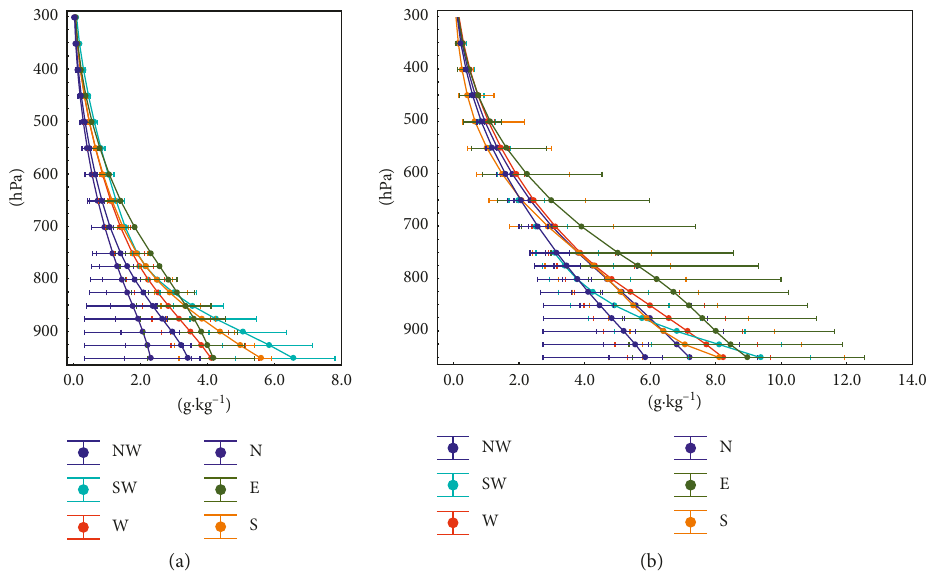
Figure 3: Monthly mean specific humidity (SHUM) vertical profiles at selected grid points (for details, see Figure 1 and Table 1); whiskers show the range defined by minimum and maximum SHUM values in a moisture region represented by the given grid point: (a) January; (b) July